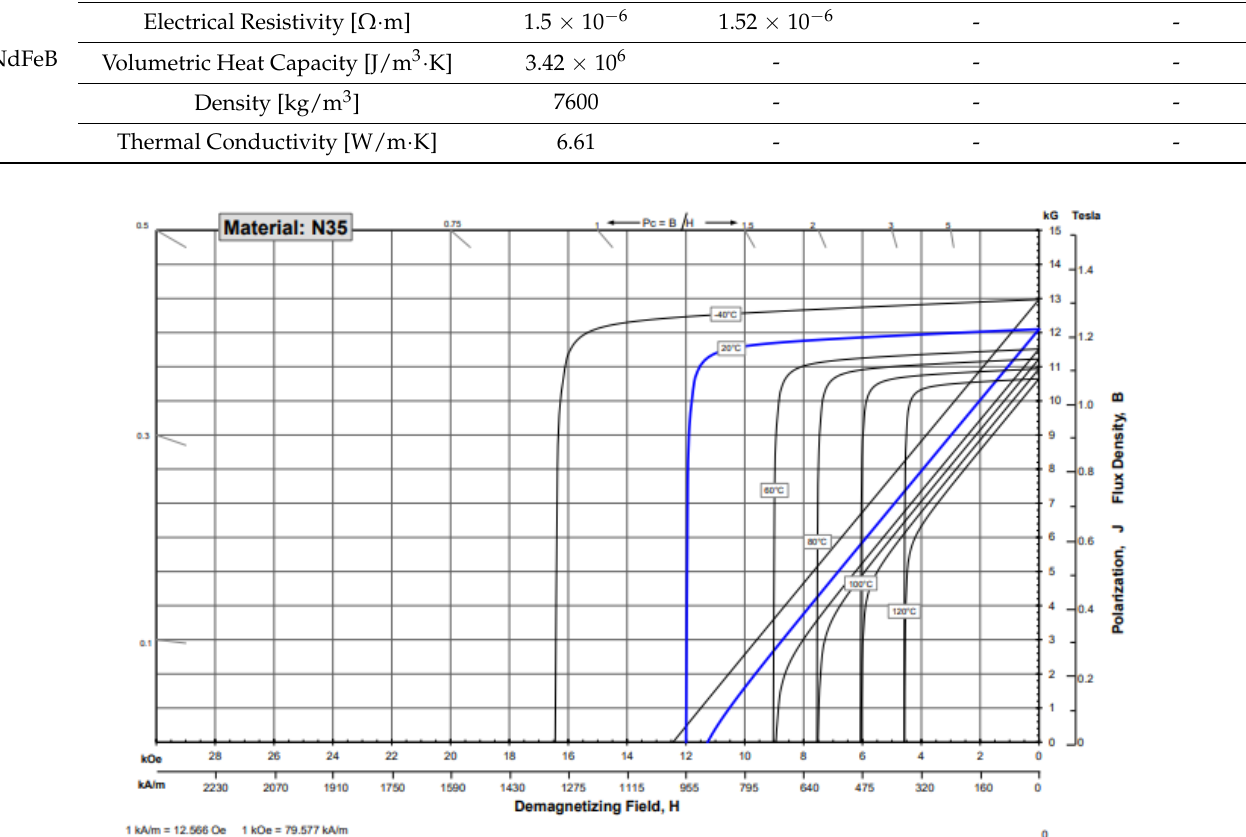
Figure 3. Demagnetization curves as a function of temperature for NdFeB